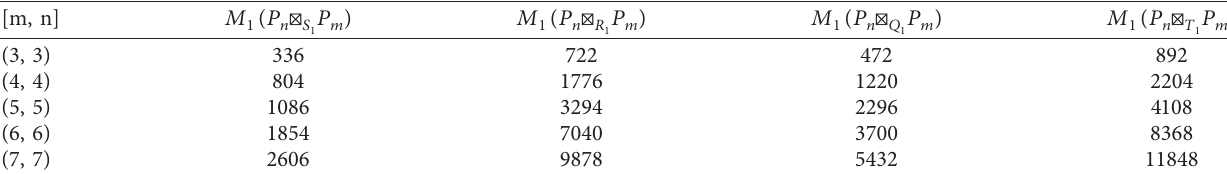
( P P ) for path graph. n ⊠ Φ 1 m 1